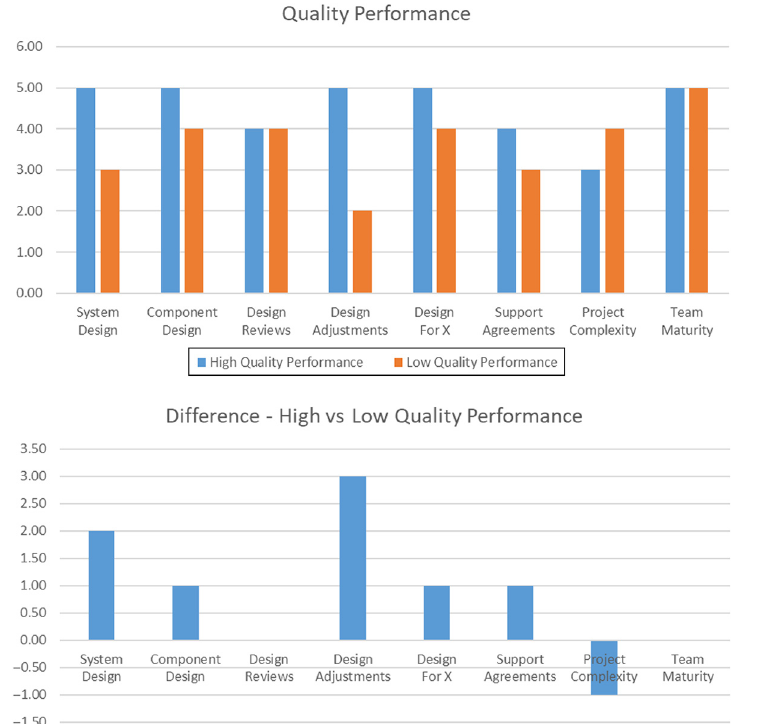
Figure 6. High- and